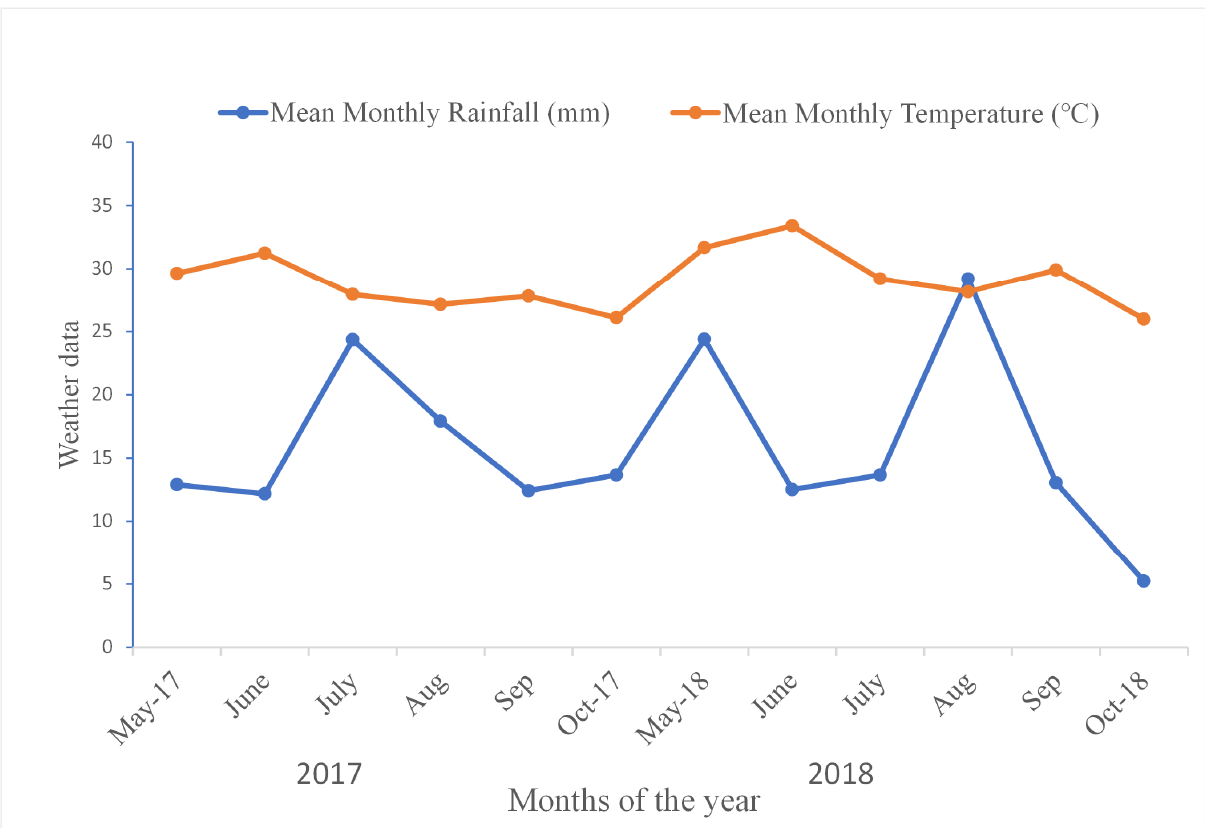
Figure 1. Mean monthly rainfall and temperature during the experimental period.